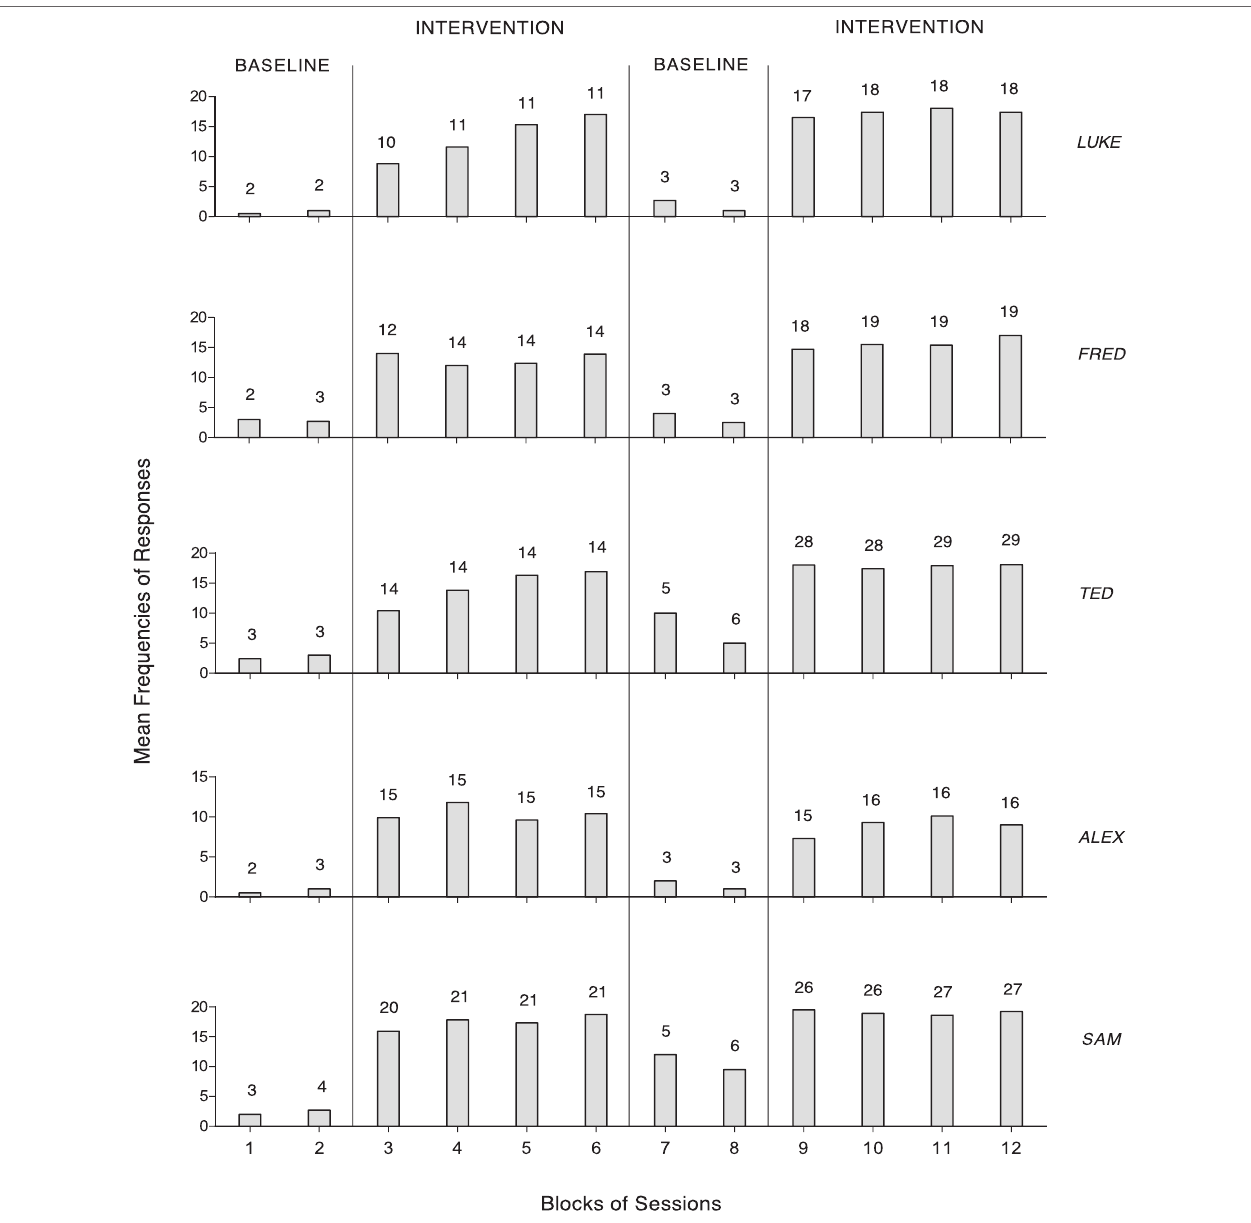
FigUre 2 | The five panels summarize the data for Luke, Fred, Ted, Alex, and Sam, which are plotted as in Figure 1